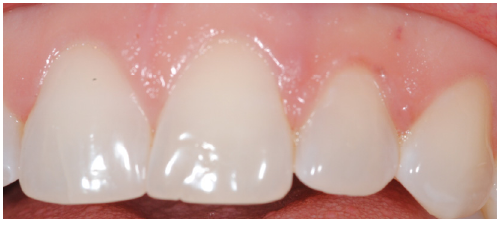
Figure A1. The buccal aspect of the region of interest after hemostasis was achieved.